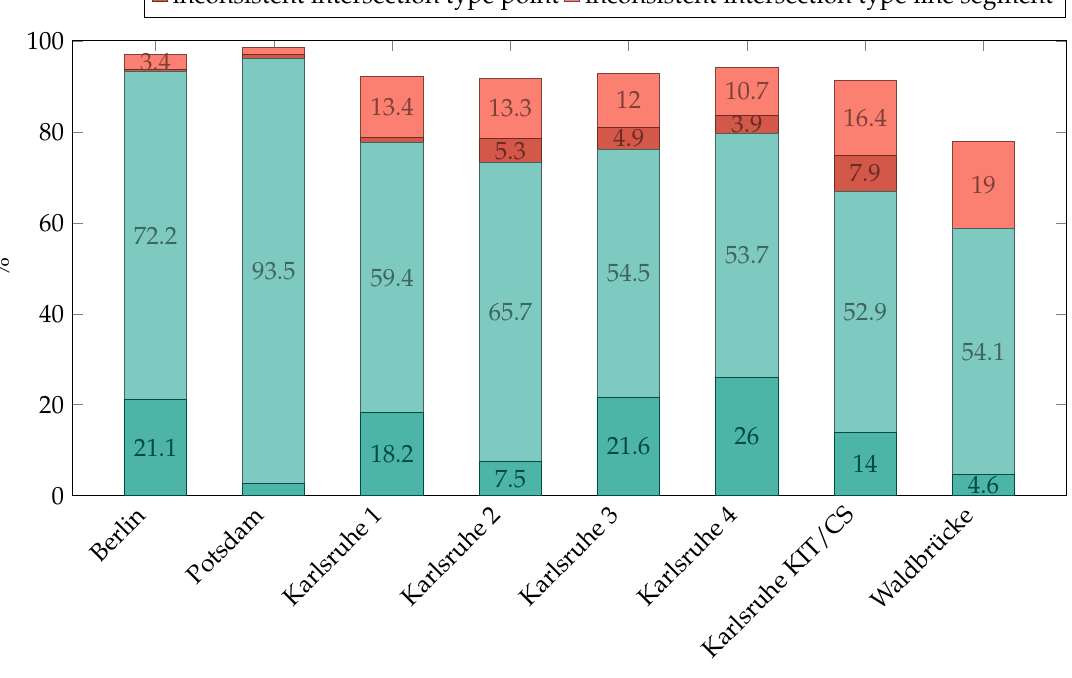
Figure 7. Topologically consistent and inconsistent configurations with point and line segment intersections. Table 1. List of CityGML data sets used in this study. Number of Number of Inconsistent